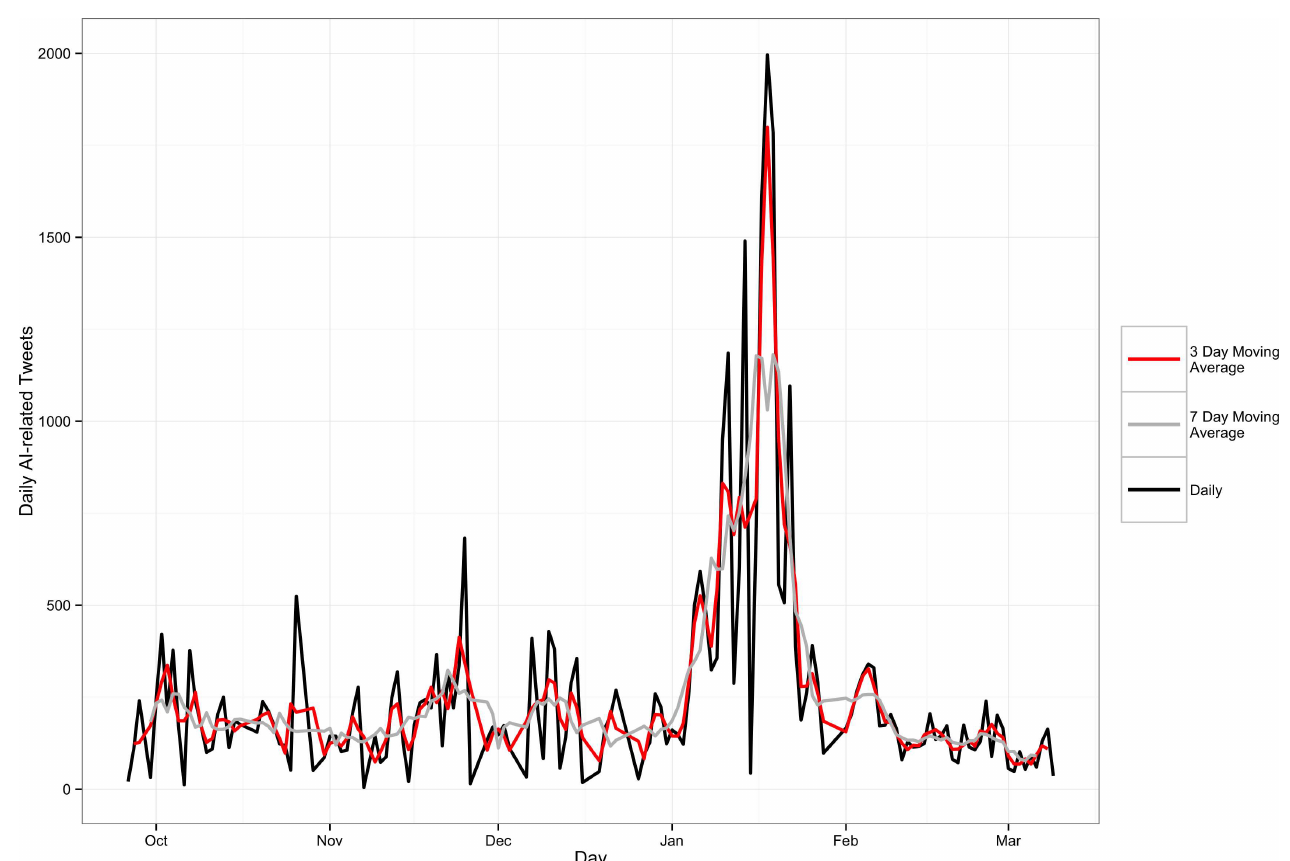
Fig 3. Time Series of AI-related Tweets including the raw count data (black), and three (red) and seven (grey) day moving